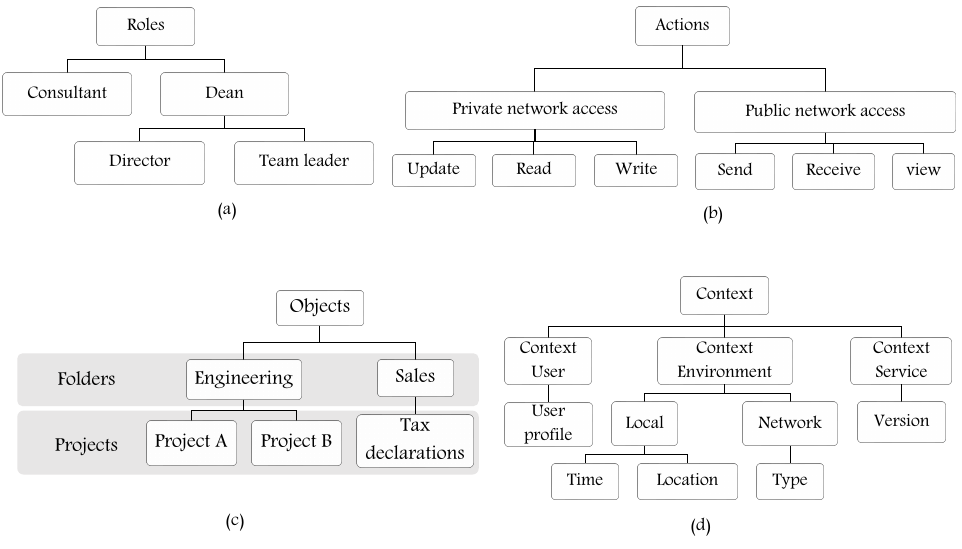
Figure 4. Examples for hierarchy of ( a ) roles; ( b ) actions; ( c ) objects; and ( d )